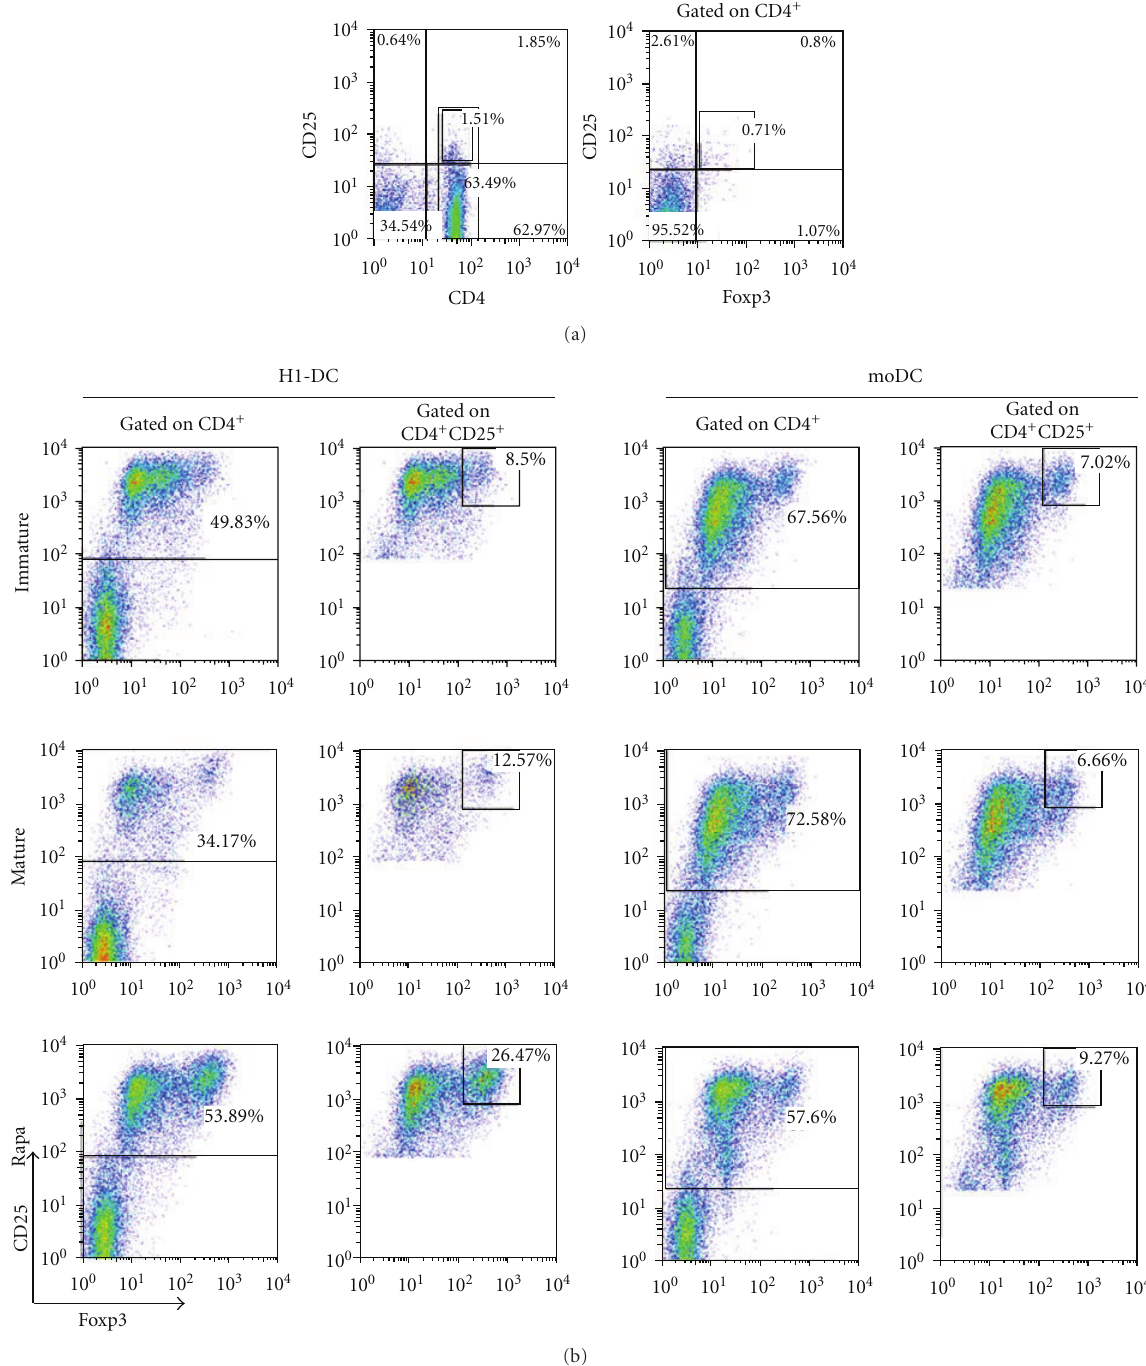
Figure 4: Enhanced capacity of rapamycin-treated H1-DC to promote Treg induction. (a) The starting population of naive CD4 + T cells was analysed by flow cytometry for the expression of CD25 and Foxp3, markers associated with commitment of T cells to the regulatory T cell lineage. (b) Rapamycin enhances the capacity of H1-DC to induce Treg cells compared to moDC. DCs were either untreated, matured with the maturation cocktail or treated with rapamycin for 3 days prior to maturation. DCs were harvested, washed, and plated at 2 × 10 5 per well with 10 6 naive CD4 + T cells per well of a 24-well plate to yield a ratio of DC: T cells of 1 :5. On day 7, cocultures were stained for CD4, CD25, and Foxp3 and analysed. Dead cells were excluded from the analysis using 7-AAD staining. Data from one experiment representative of 4 independent experiments are